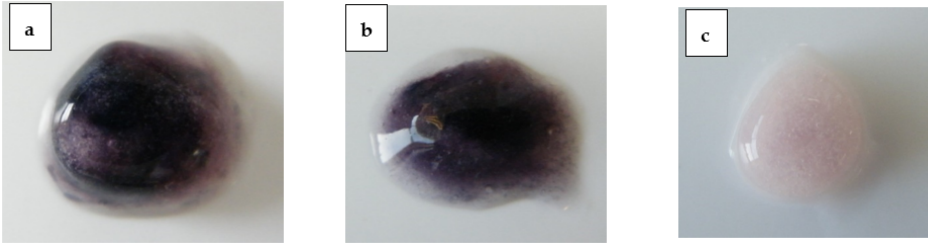
Figure 8. ( a ) Fosphenytoin compact at 3 hours, ( b ) fosphenytoin compact at 7 hours, ( c ) hydrated fosphenytoin compact with no ALP at 7 hours.